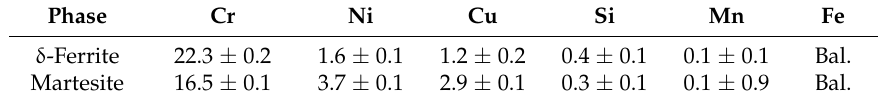
Table 2. The measured chemical composition of 17-4 PH stainless steel micro-constituents (all in wt. %).